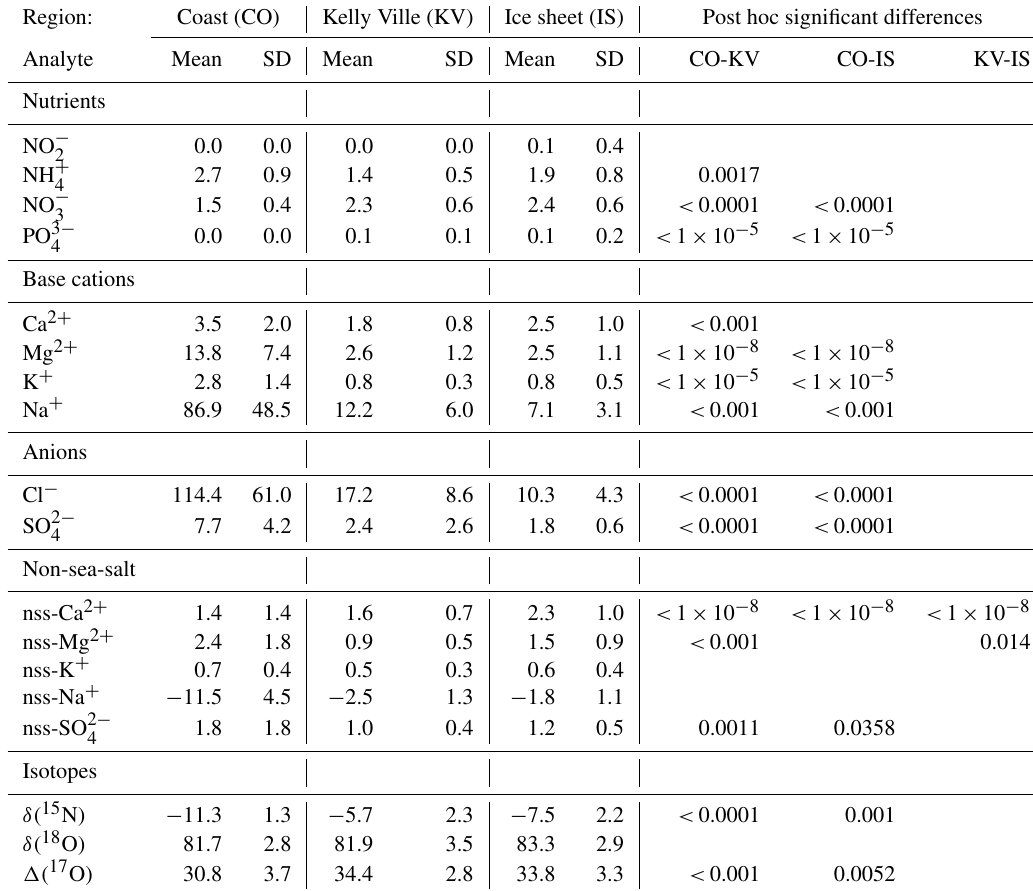
Table 4. Comparison of aggregated snowpack chemistry ( n = 24 per region), derived non-marine concentrations of major ions (all in µmolL − 1 ) and isotopic composition (‰). See text for details of post hoc pairwise comparisons. Coast is CO, Kelly Ville is KV, ice sheet margin =